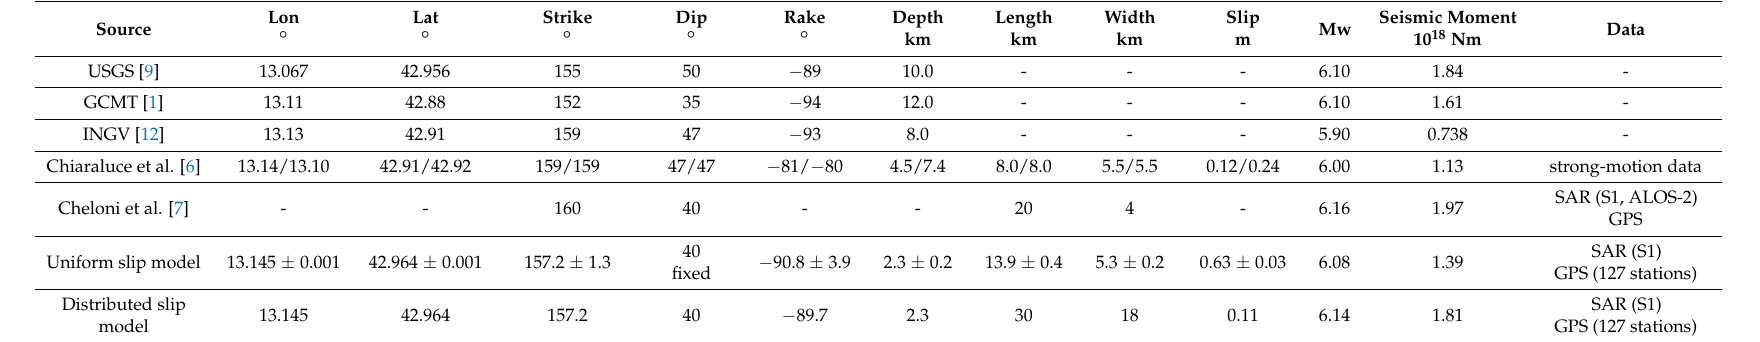
Table 4. Source parameters of the 26 October 2016